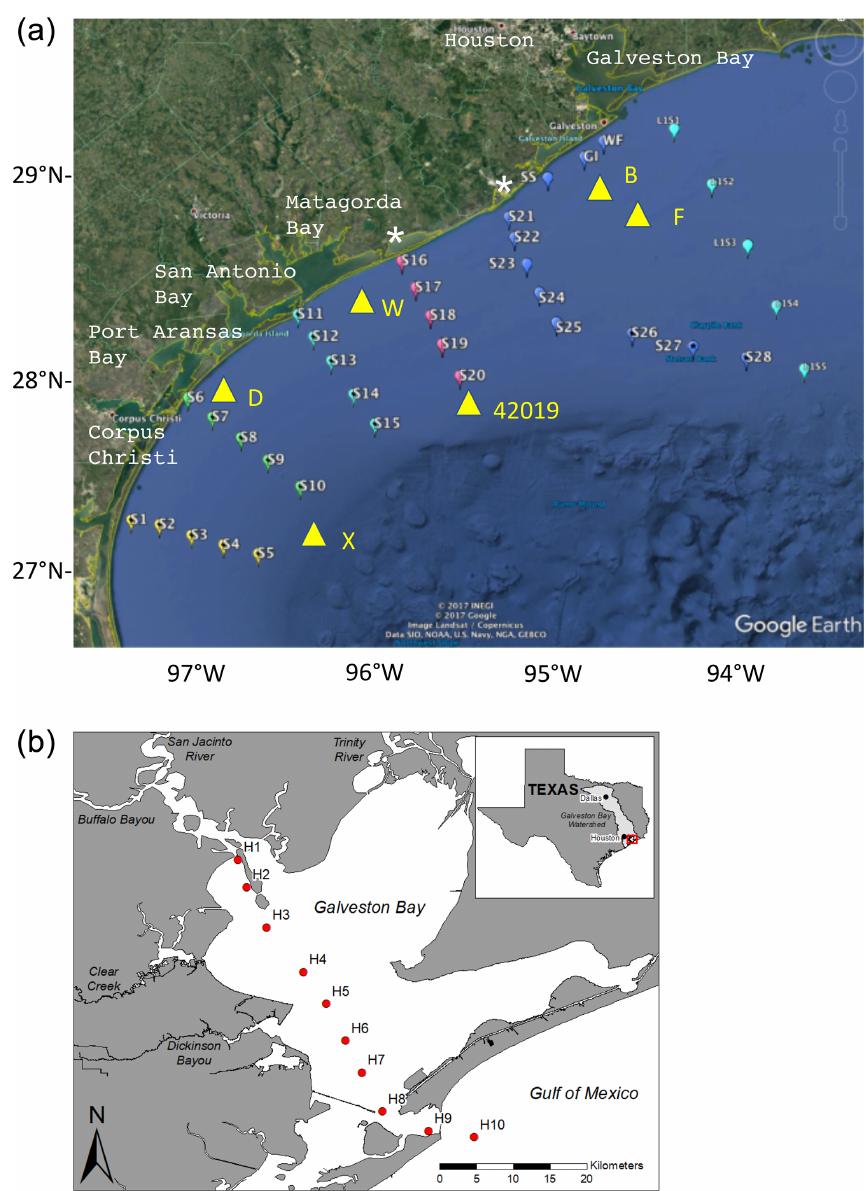
Figure 2. (a) Stations occupied during the four cruises. Only stations S1–S25 and the inshore stations GI, SS and WF were occupied during June and August. All stations shown were occupied in the 22–27 September cruise and in November. Only the two inshore stations on each line were occupied during the second September cruise. Yellow triangles show positions of TABS moorings B, D, F, W and X and NOAA buoy 42019. White stars show the mouths of the Colorado River (near station 16) and Brazos River (near station 21). Data from stations 11–15 are shown in Figs. 5 and 6 and in the Supplement. (b) Galveston Bay and vicinity showing Trinity and San Jacinto rivers and stations discussed in Fig.